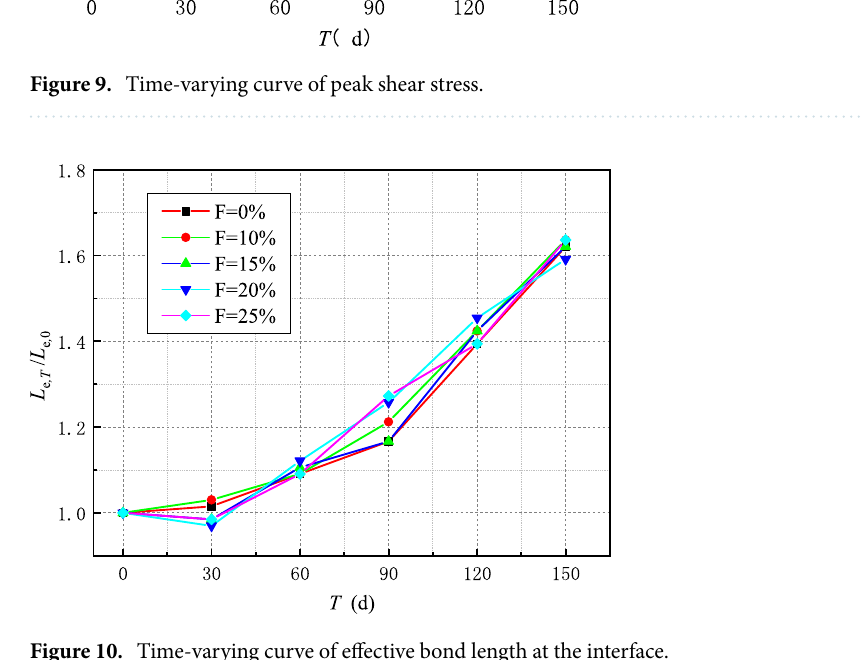
Figure 10. Time-varying curve of effective bond length at the